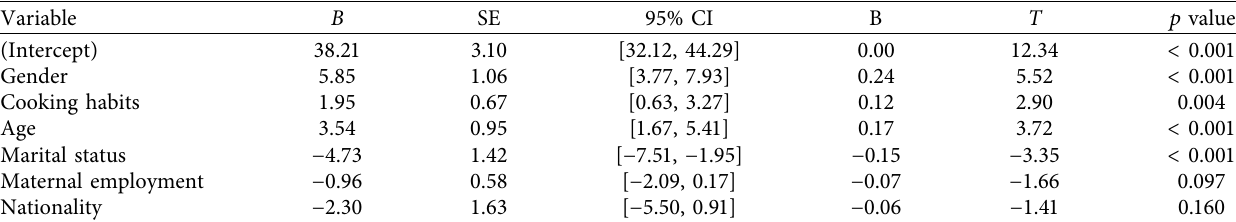
Table 6: Results for linear regression with gender, cooking habits, age, marital status, maternal employment, and nationality predicting percentage of correct FHP. Variable B Gender Age 3.54